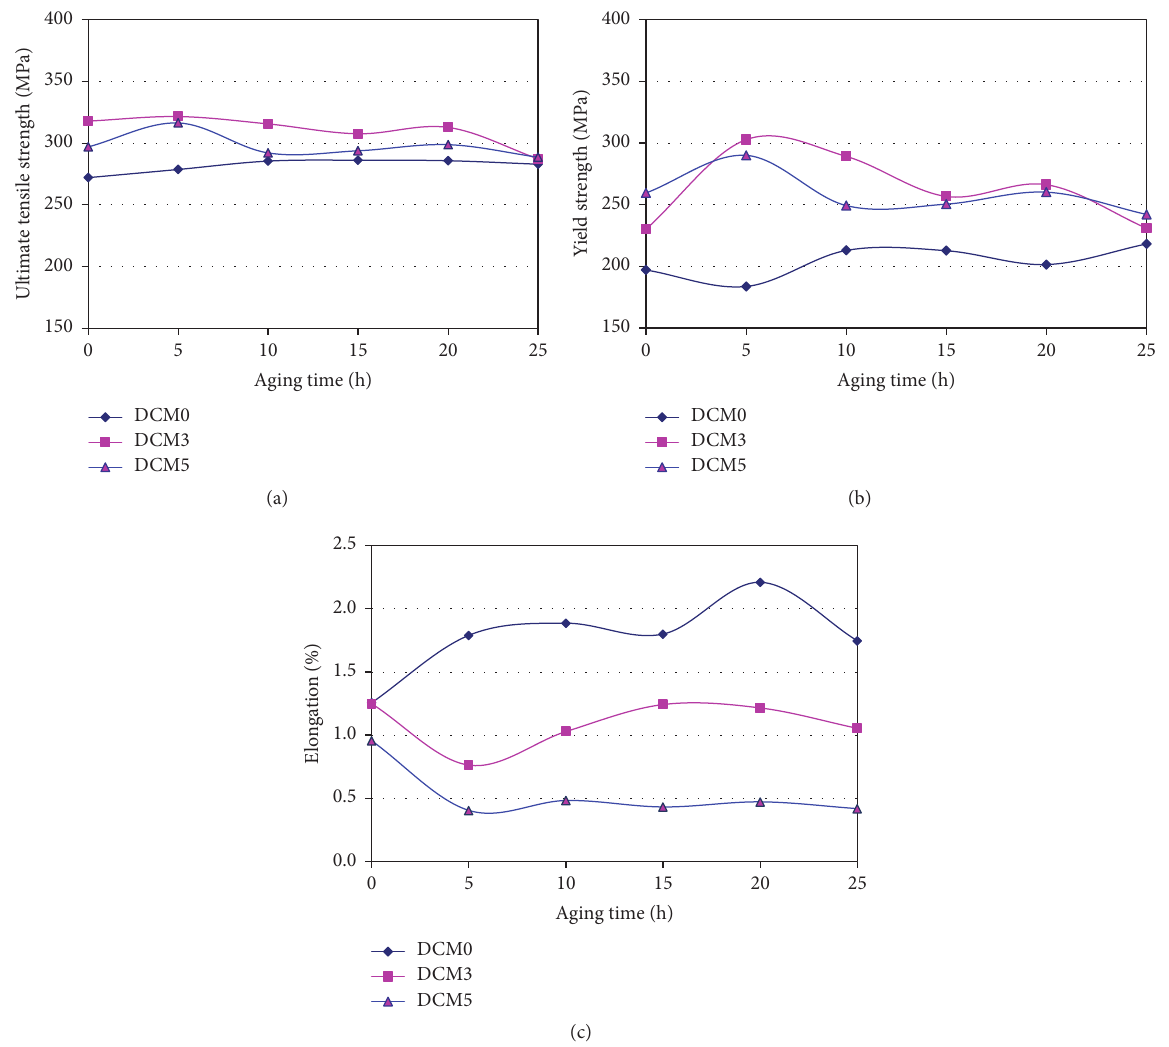
Figure 8: Variation in the alloy tensile properties as a function of aging time at 220 ∘ C: (a) UTS, (b) YS, and (c) % El.